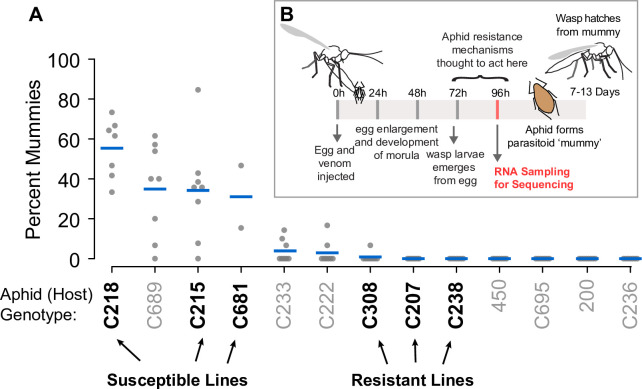
A. Experimental parasitism of aphid genotypes. The y-axis shows the percent of mummies from each dish (replicate). Each replicate is shown with a grey point, with aphid genotypes along the x-axis; the mean parasitism rate for each genotype is shown with a bar. The susceptible and resistant genotypes used in the transcriptome sequencing are highlighted in bold and with arrows along the bottom of the figure. B. Putative life-cycle of aphid-wasp interactions. Aphid resistance mechanisms are thought to act between 72hrs and 96hrs after wasp parasitism.